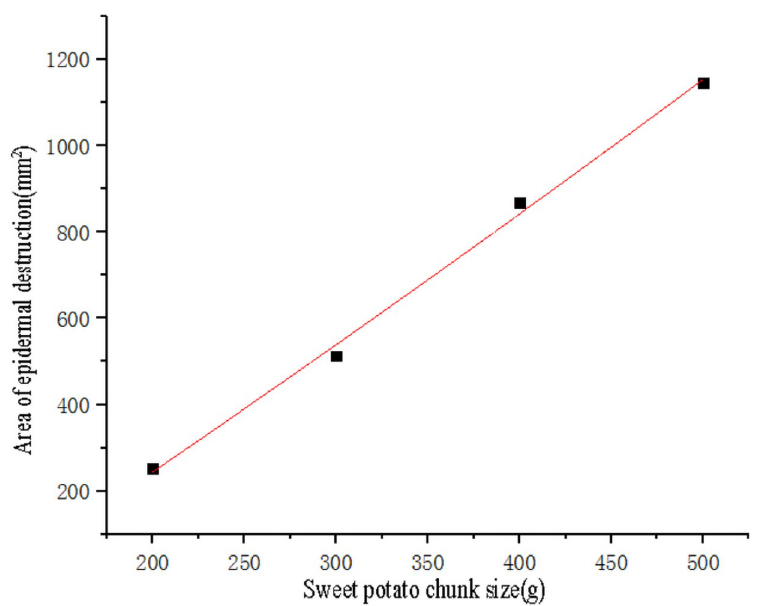
Fig 18. Fitting curve of sweet potato chunk size and the area of epidermal destruction.